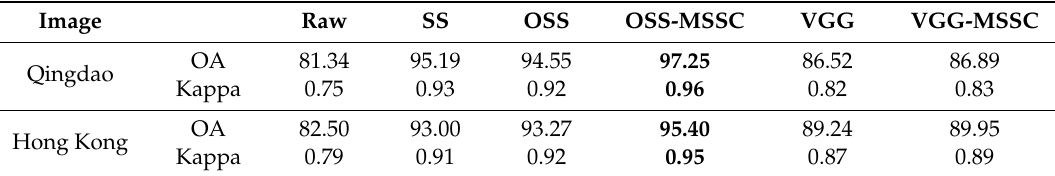
Table 4. Classification